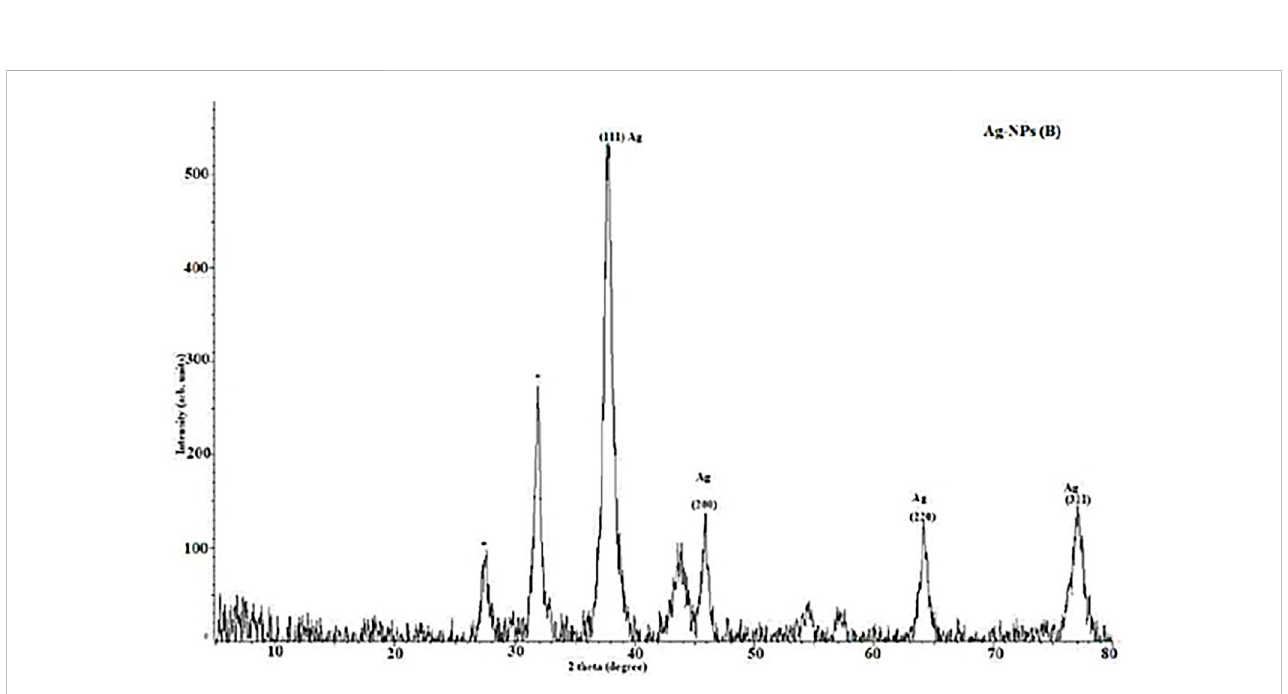
FIGURE 5 XRD of silver nanoparticles synthesized from the Piper cubeba extract.